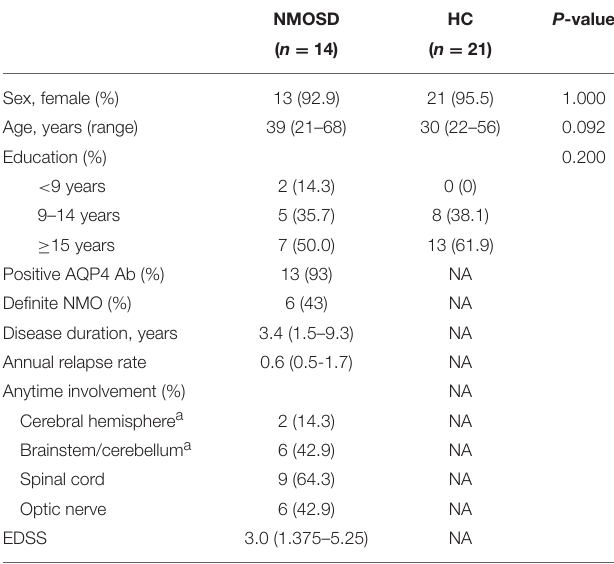
TABLE 1 | Demographics and clinical characteristics of study